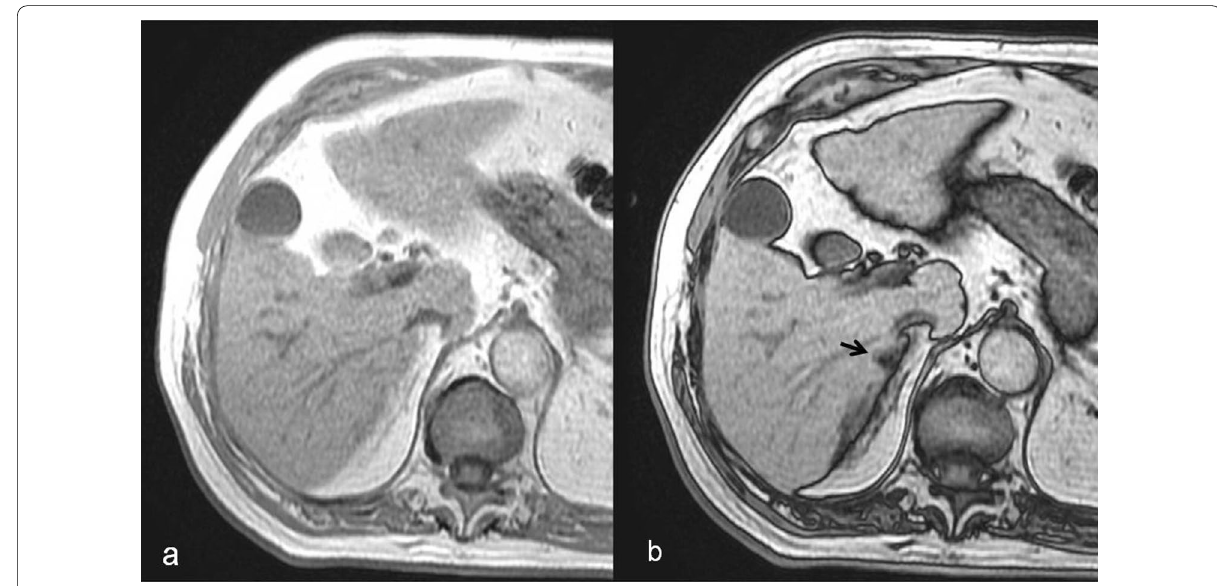
Fig. 1 a , b —Axial in-phase ( a ) and out-of-phase ( b ) MR images exhibit signal drop of the subcapsular lesion in the VI segment (black